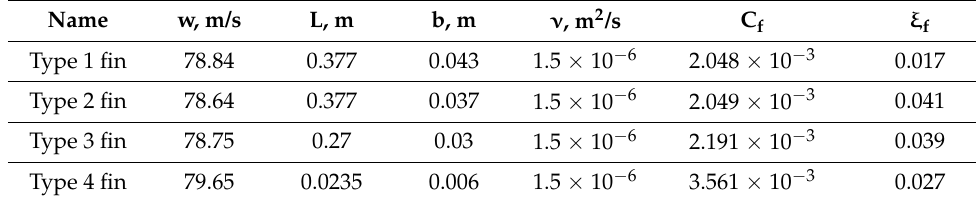
Table 2. Friction coefficient as calculated.